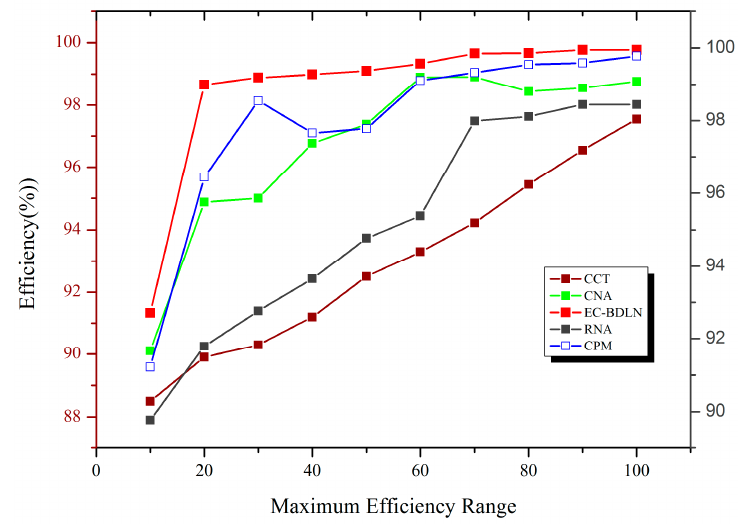
Figure 8. Estimation using mean residual square error analysis.